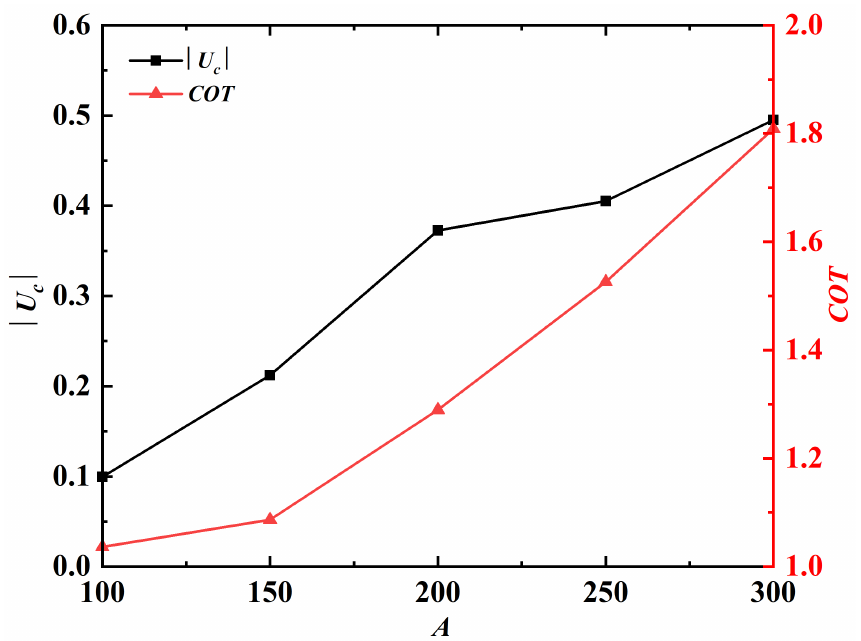
Figure 9. U c and COT as a function of A . The absolute value of U c is plotted here since the propulsor is swimming in the negative x -direction.